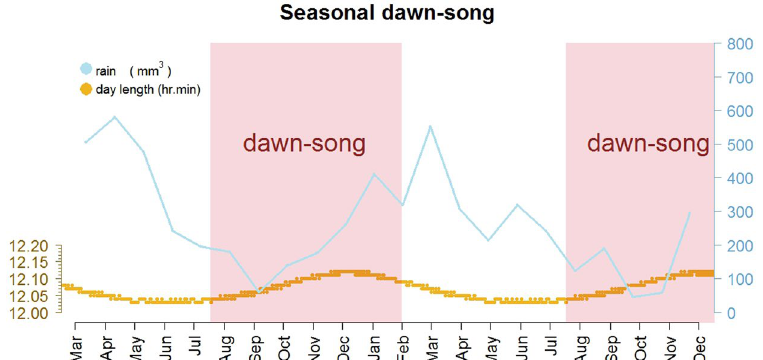
Figure 1. Seasonal dawn-song is timed according to annual increases in day length. Data were collected from March 2011 until December 2012. Variations in monthly rainfall (mm 3 ) are shown in blue. The small changes in day length duration (hours from sunrise to sunset) over the year are shown in yellow. Seasonal periods in which dawn-song is produced by males are shown in red. The seasonal timing of dawn-song is highly regular between years.